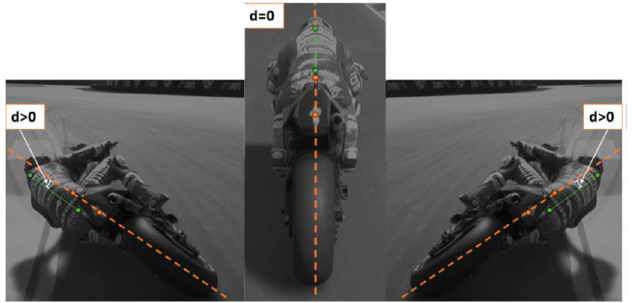
Figure 13. Distance d between the driver’s center of gravity and the vehicle’s rolling axle.